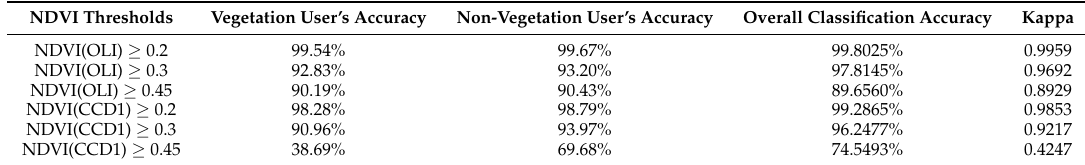
Table 6. The classification accuracy evaluation table using different threshold. NDVI Thresholds